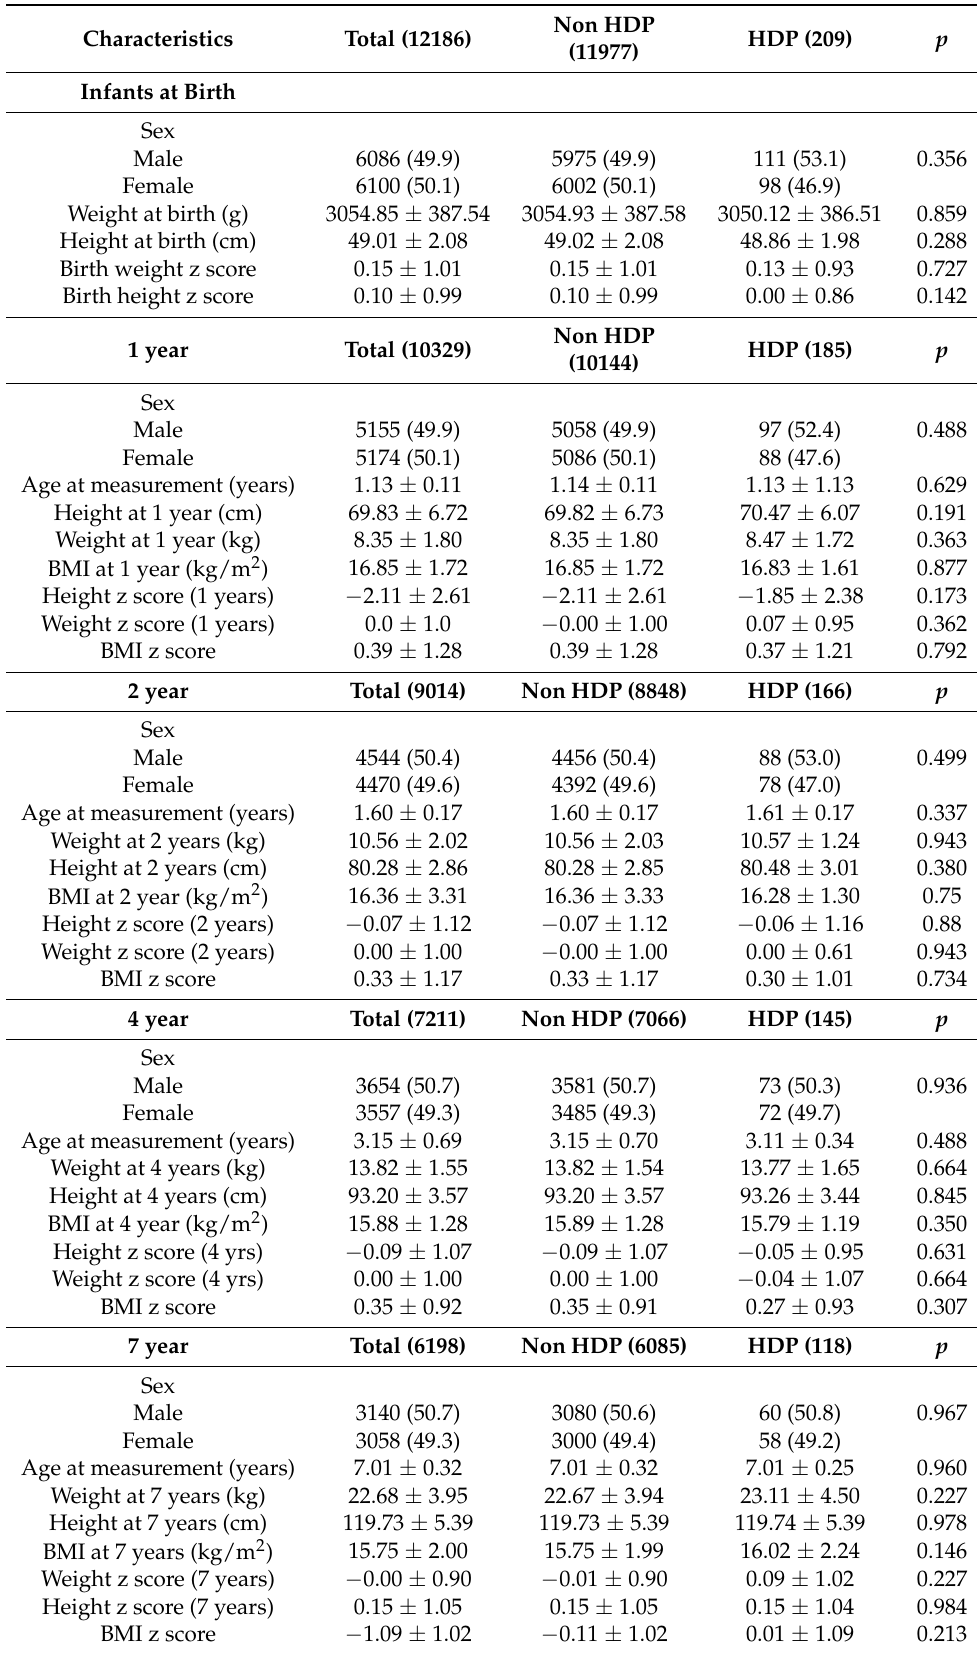
Table 1. Demographic information of children from birth to seven